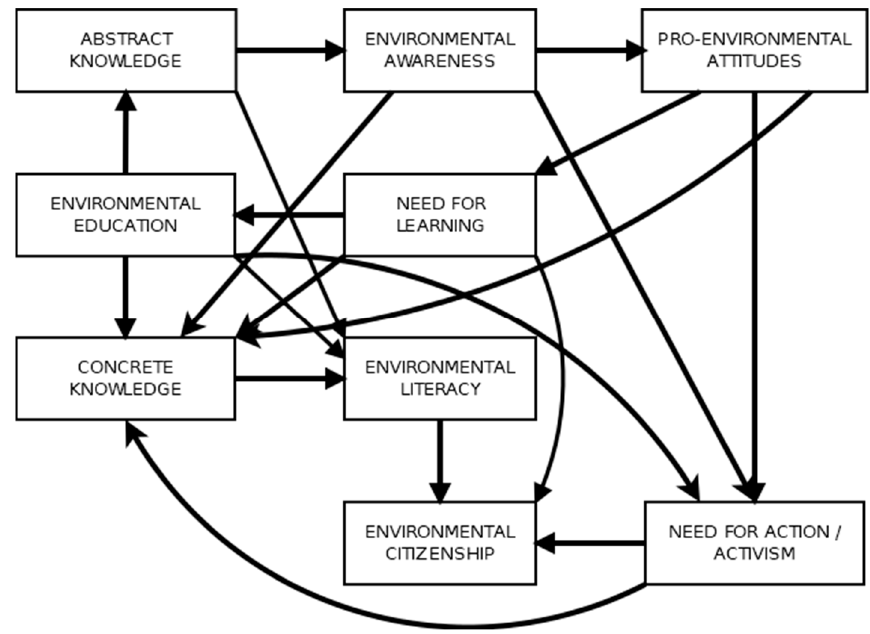
Figure 3. The updated Simple Model of Environmental Citizenship.